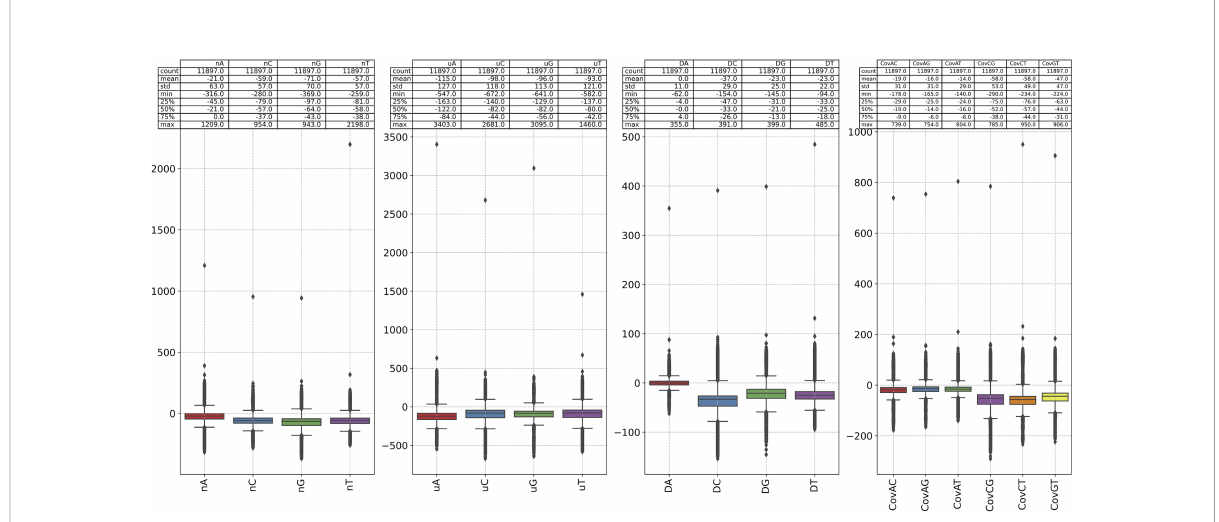
FIGURE 6 The difference between the 1-mer NVC of each sequence in our dataset and the 1-mer NVC of the reference sequence (NC_001802). The 1- mer NVC of the RefSeq is calculated fi rst, and the 1-mer NVCs of the rest sequence subtracted